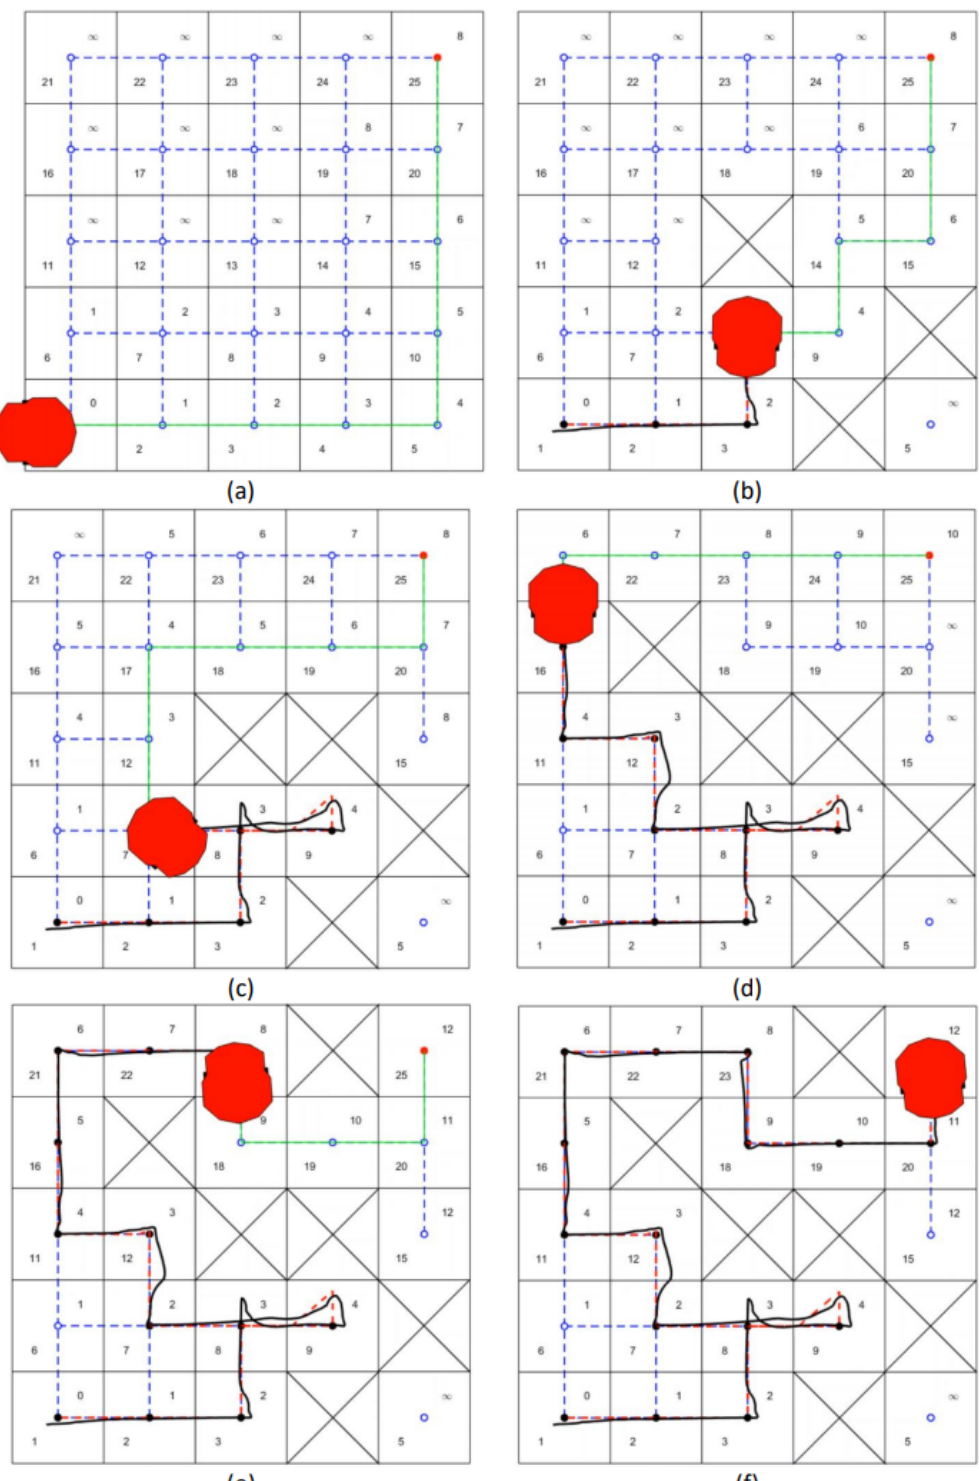
Figure 8. Experiment 1: The goal achievement. Snapshots of the route traveled, from the initial state ( a ) to the final one ( f ), passing by some intermediate stages ( b – e